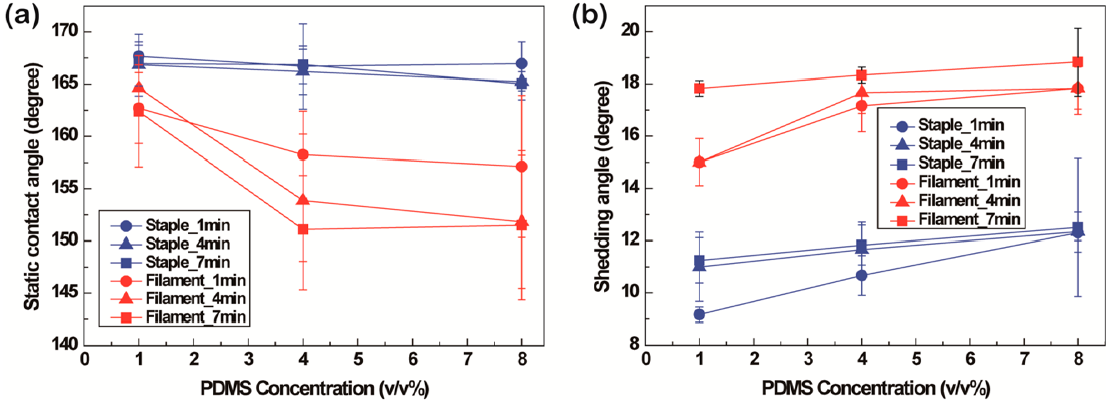
Figure 5. Static contact angles ( a ) and shedding angles ( b ) of staple and filament fabrics after 1, 4, and 8 v / v % PDMS coating for 1, 4, and 7 min.